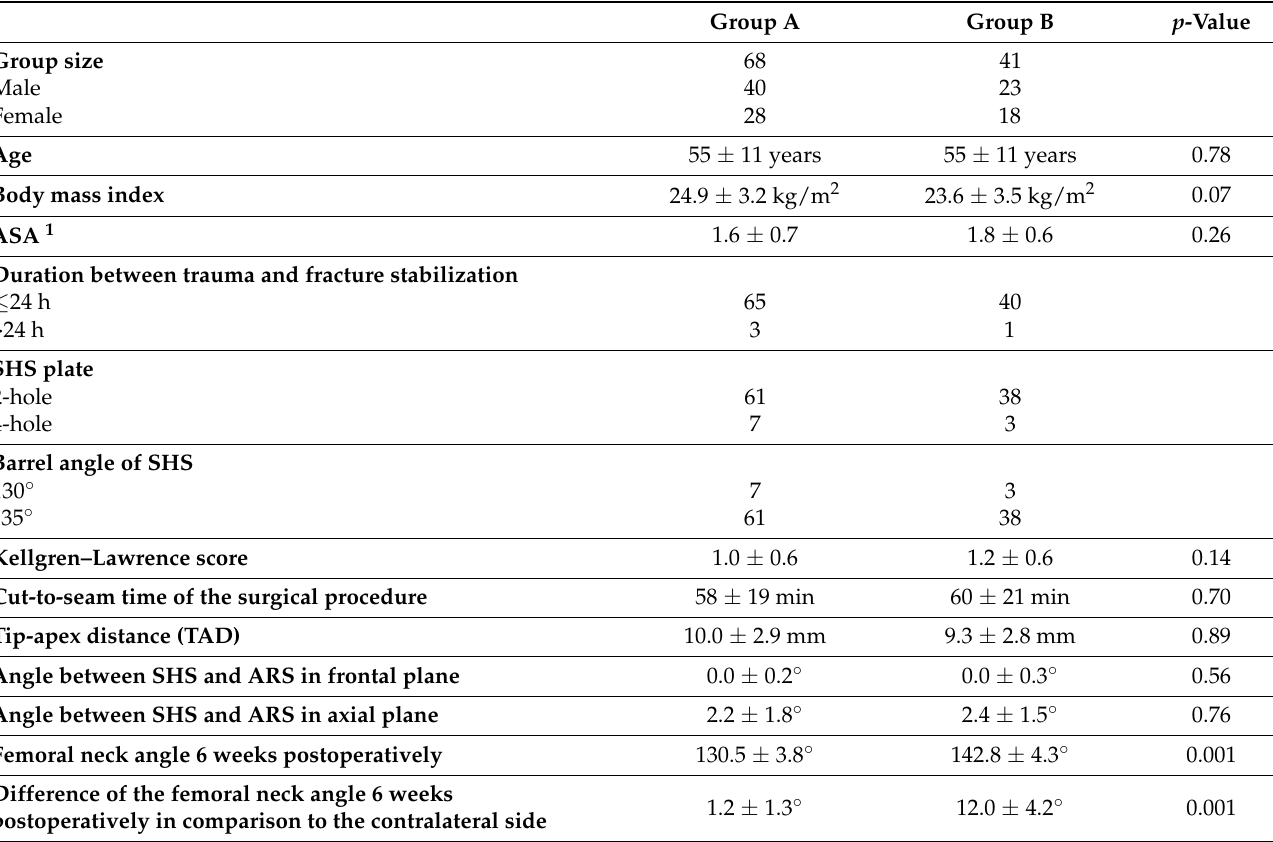
Table 1. Overview of the patient cohort with Garden type III femoral neck fractures divided into group A (anatomic reduction) and group B (valgus reduction). Values are presented as mean ± standard deviation or as total number of